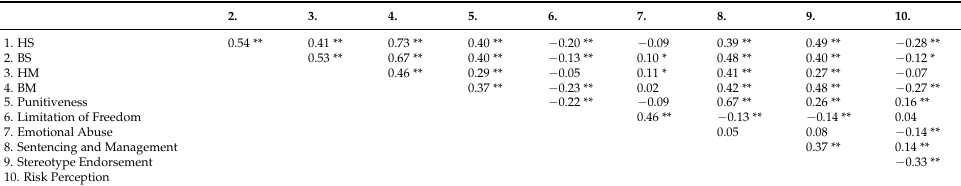
Table 2. Pearson’s correlations between variables.